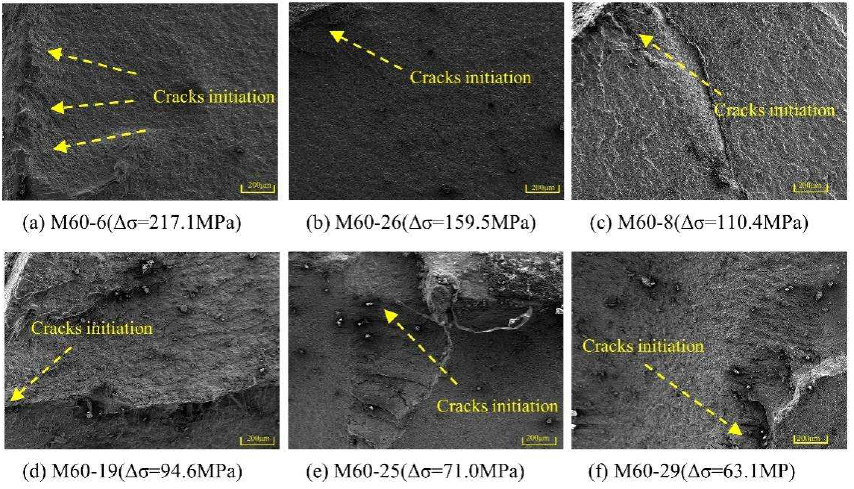
Figure 12. The microscopic morphology of the fatigue source at different stress amplitudes.